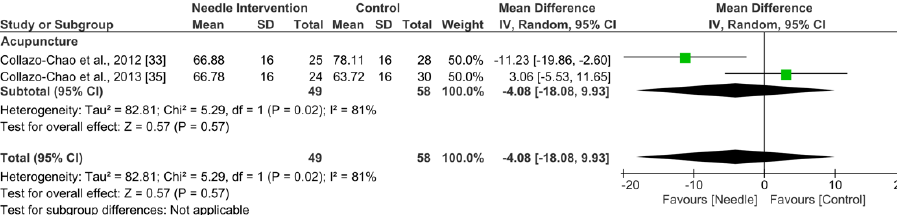
Figure 6. Forest plot for FIQ: 3–6